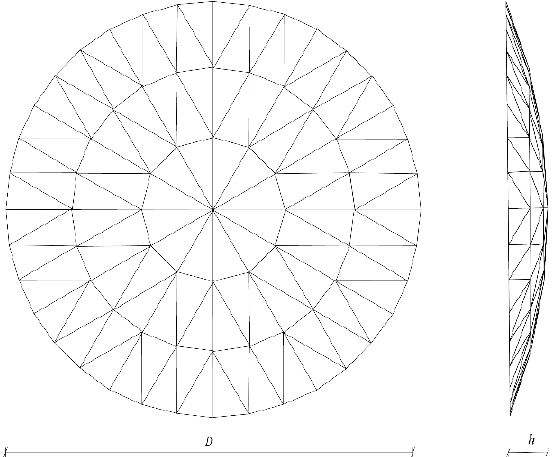
Figure 1. K8 single-layer latticed shell model.